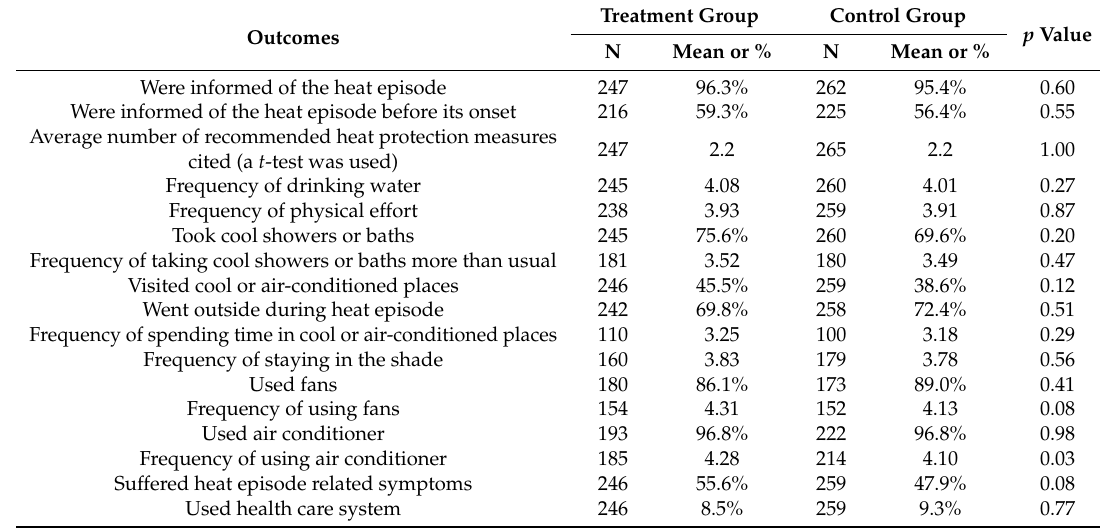
Table 3. Ex ante comparison between treatment and control groups on outcome variables.